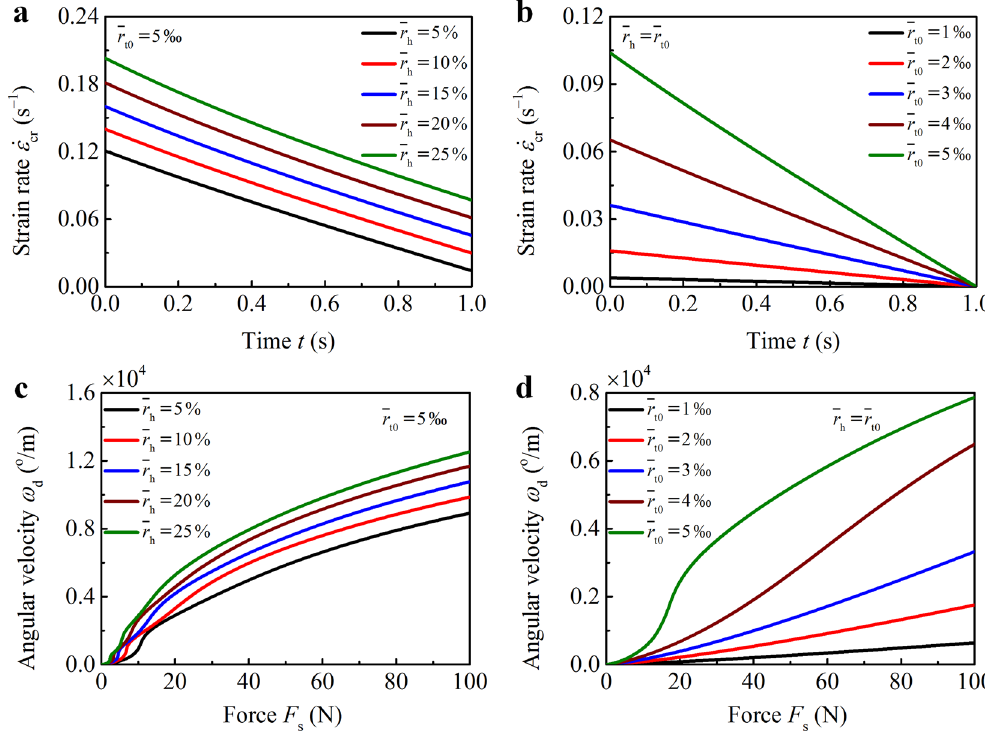
 ε of the string is plotted with time cr